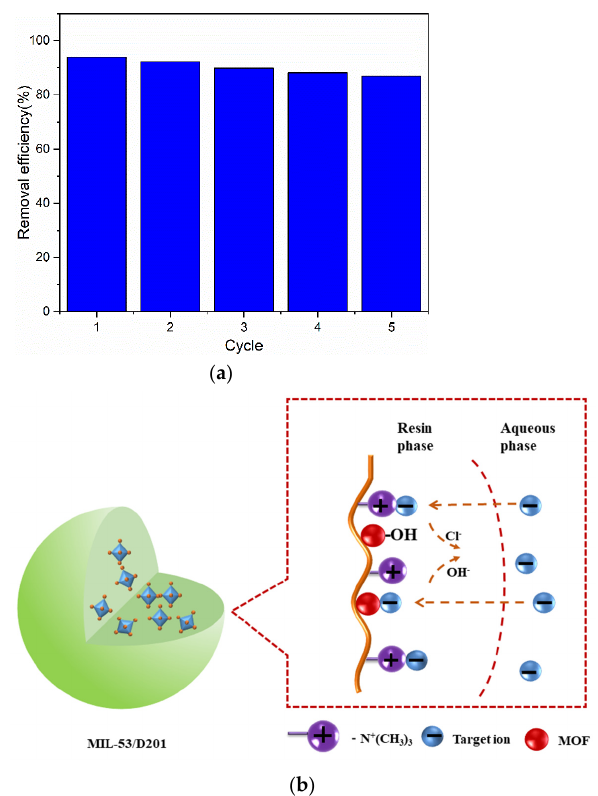
Figure 9. Adsorption regeneration diagram ( a ) and adsorption mechanism diagram ( b ) of removing azlocillin sodium by MIL-53/D201.